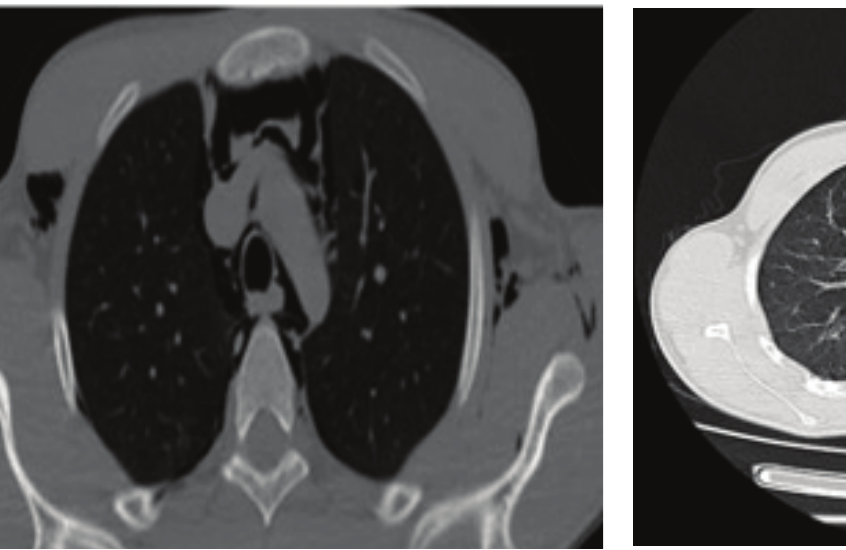
Figure 4 - Diffuse pneumomediastinum on computed tomography (CT) of the second